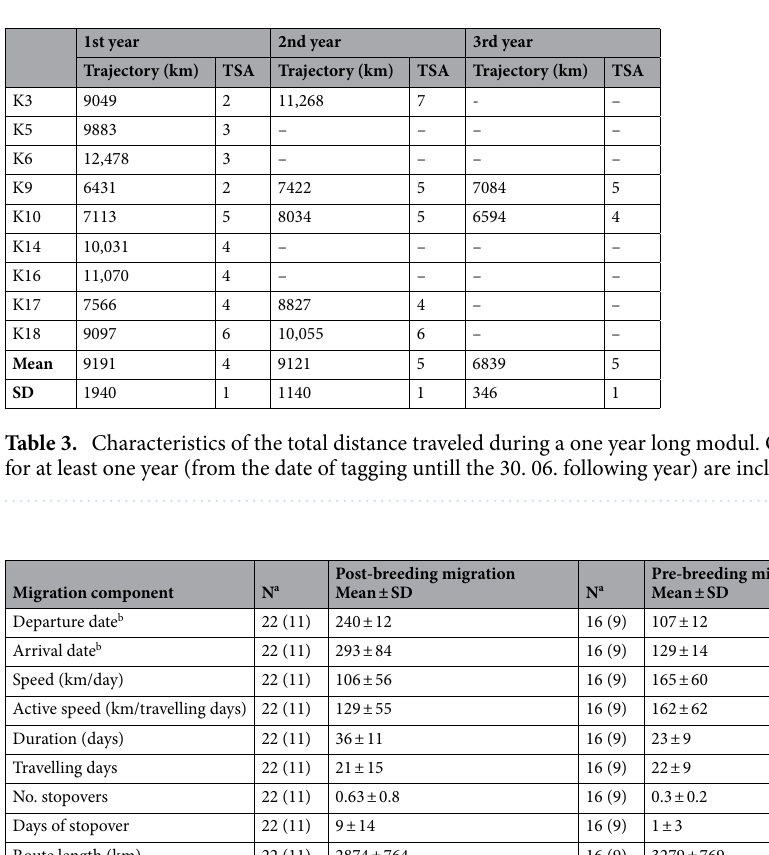
Table 4. Estimates of post and pre-breeding migration by tagged Black Kites from 2018 to 2021. a Number of migration episodes (number of tagged individuals). b Julian date (1 = 1 January). Birds that died before or during migration were omitted from the test. Differences in mean values were tested by Mann–Whitney U test for nonparametric data and significant results are highlighted in bold.